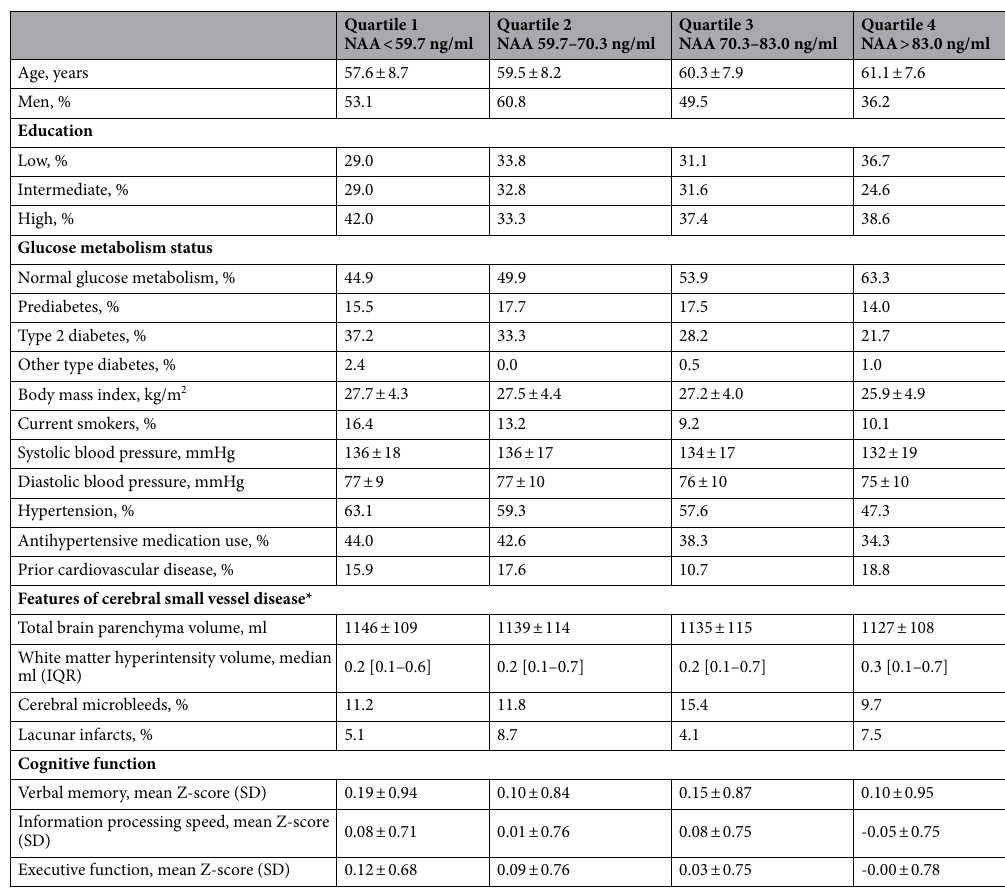
Table 5. Subject characteristics by NAA quartiles. *Data available in n = 533. NAA = serum N-acetylaspartate.